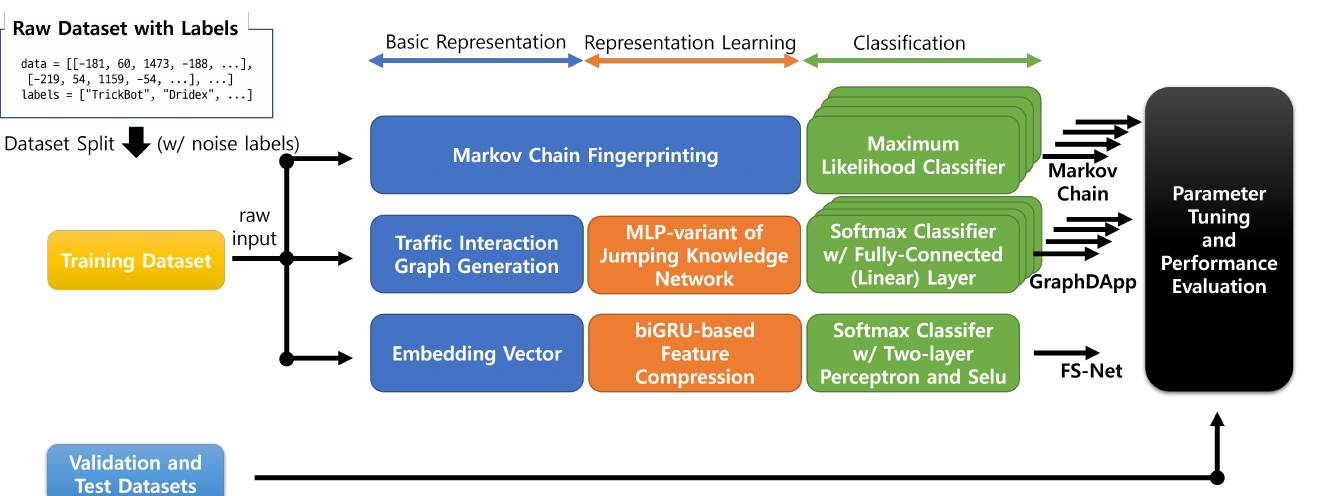
Figure 3. An overview of our evaluation framework for the malware family classification